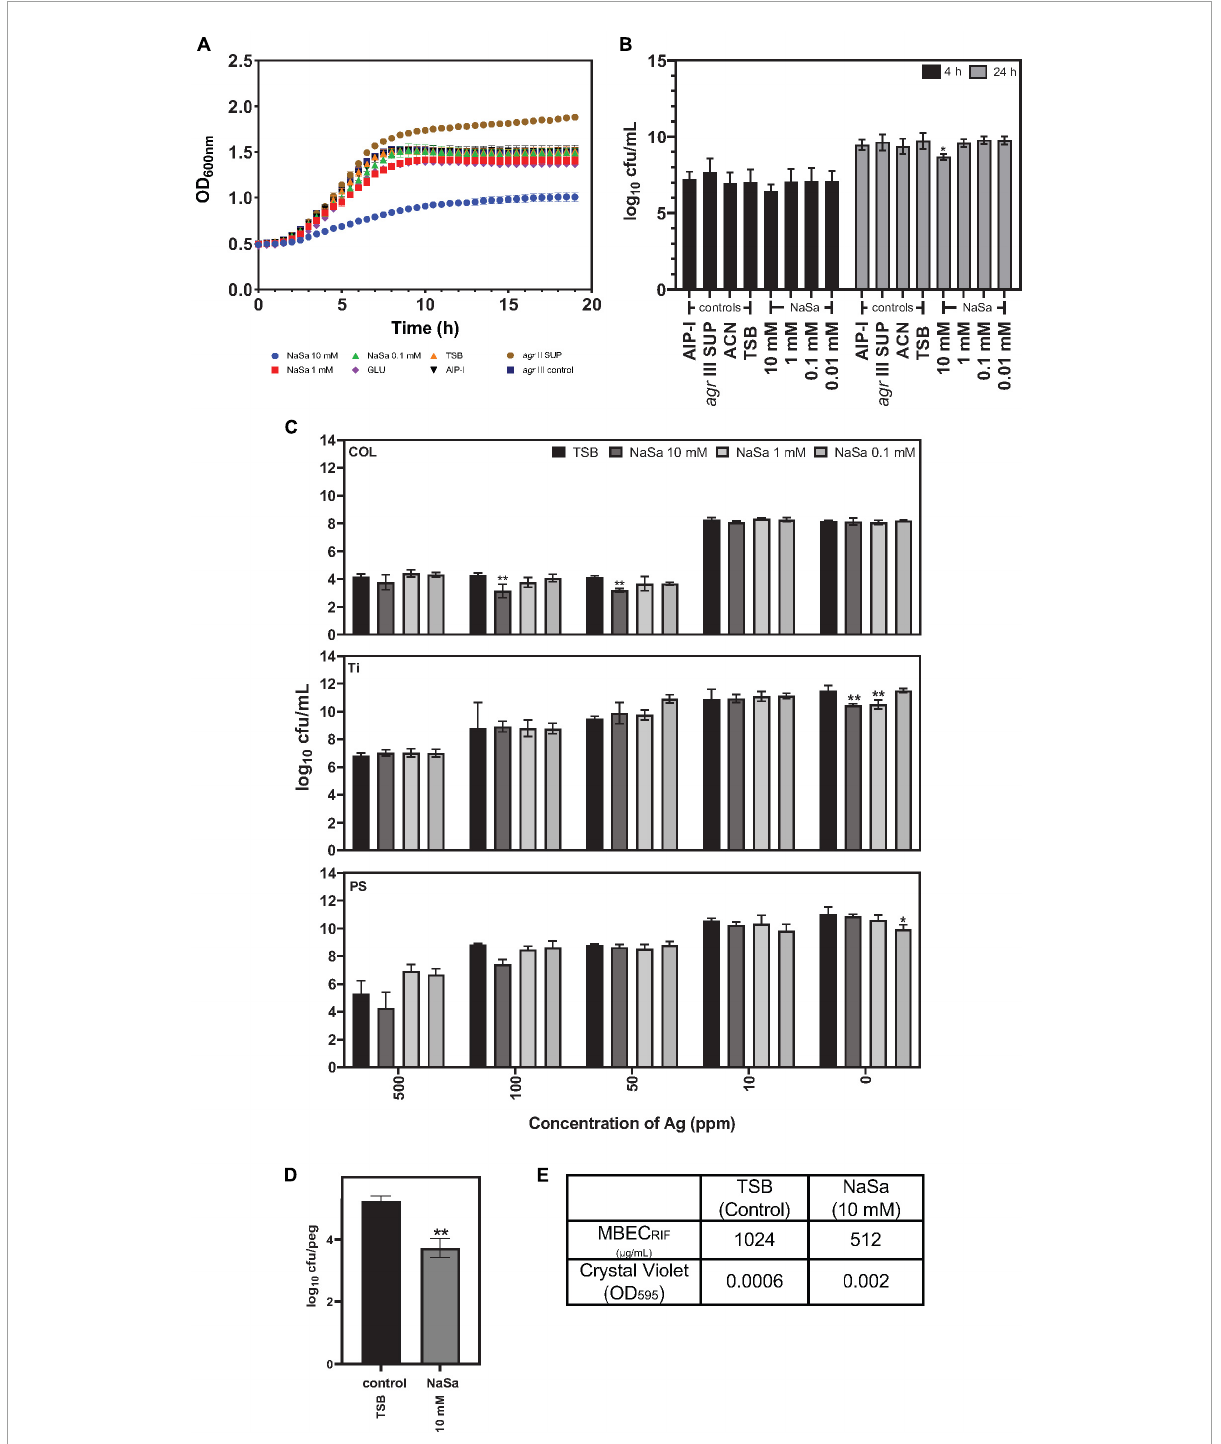
FIGURE7 NaSa affects S. aureus planktonic cell viability and biofilm tolerance toward antimicrobials. Effect of NaSa on growth kinetics during 24 h (A) and viability after 4 h and 24 h (B) of planktonic S. aureus ATCC 25923. Influence of NaSa pretreatment on the action of silver (Ag) against S. aureus grown in a 3D collagen model (COL), titanium (Ti) and polystyrene (PS) (C) . Effect of NaSa on the formation of biofilms on pegs of the Calgary biofilm device (D) and its tolerance toward rifampicin (RIF) (E) . Data represent the means from three independent experiments ± SD . * P ≤ 0.05, ** P ≤ 0.01, statistically significant to TSB (Tryptic Soy Broth) as media using one-way ANOVA Dunnett’s test. GLU, glucose; AIP-I, Autoinducing Peptide-I; SUP, supernatant; ACN, acetonitrile, used as AIP-I diluent